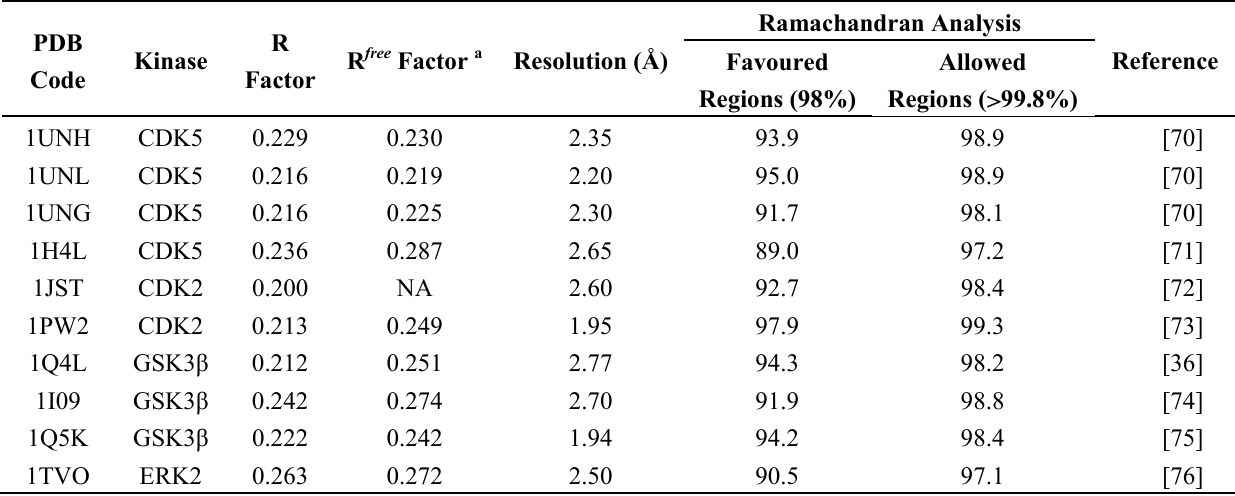
Table 3. Crystal structures used in homology model building detailing the indicators of refinement associated with each structure. a NA indicates that the data was not available.